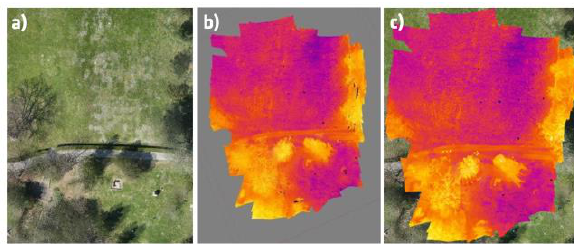
Figure 2: Orthoimages in the VIS and TIR range of the Pratolino Park in Tuscany (Italy). In particular, a) refers to a part of the VIS orthoimage, b) represents the thermal orthomosaic and c) the overlapping between the two